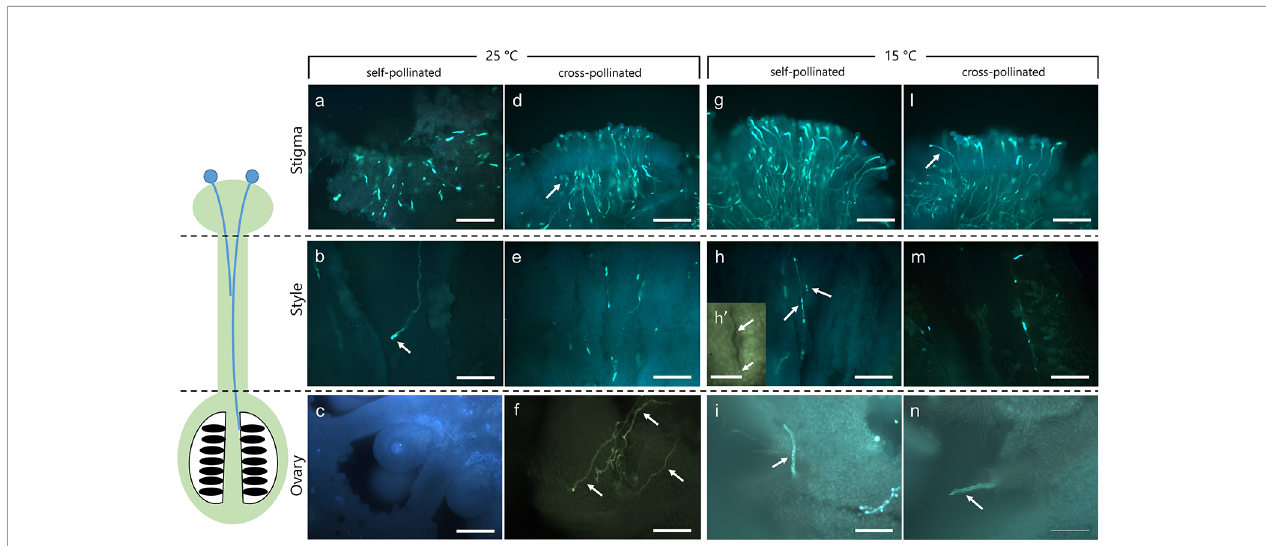
FIGURE 1 | Dissection of pistils in compatible and incompatible crosses at 25°C and 15°C. Aniline blue staining of self-pollinated (incompatible crossing) and cross- pollinated (compatible crossing) pistils at 25°C (A – F) and 15°C (G – N) . (A) In the incompatible crosses at 25°C the stigmatic region showed a few elongating pollen tubes (arrow). (B) Pollen tubes were observed in the stylar canals close to the stigma. Pollen tube growth stopped in the upper part of the style (arrow). (C) In the ovary, pollen tubes were absent. (D) In compatible crosses at 25°C, numerous pollen tubes were observed in the stigma (arrow). (E) Pollen tubes grew along the style, reaching the ovary (F) (arrows). (G) Stigma of self-incompatible cross at 15°C showing numerous pollen tubes. (H) Median portion of styles as observed in cross-section. Stylar canals have several pollen tubes (arrows) as also highlighted by the cross-sectioned stylar canal in H ’ . (I) Ovary region where pollen tubes were observed. (L) In compatible crosses at 15°C, some pollen tubes (arrow) were evident in compatible stigmas and along the style (M) , reaching the ovary ( N , arrow). Scale bars: 200 m m, except for (H) ’ (100